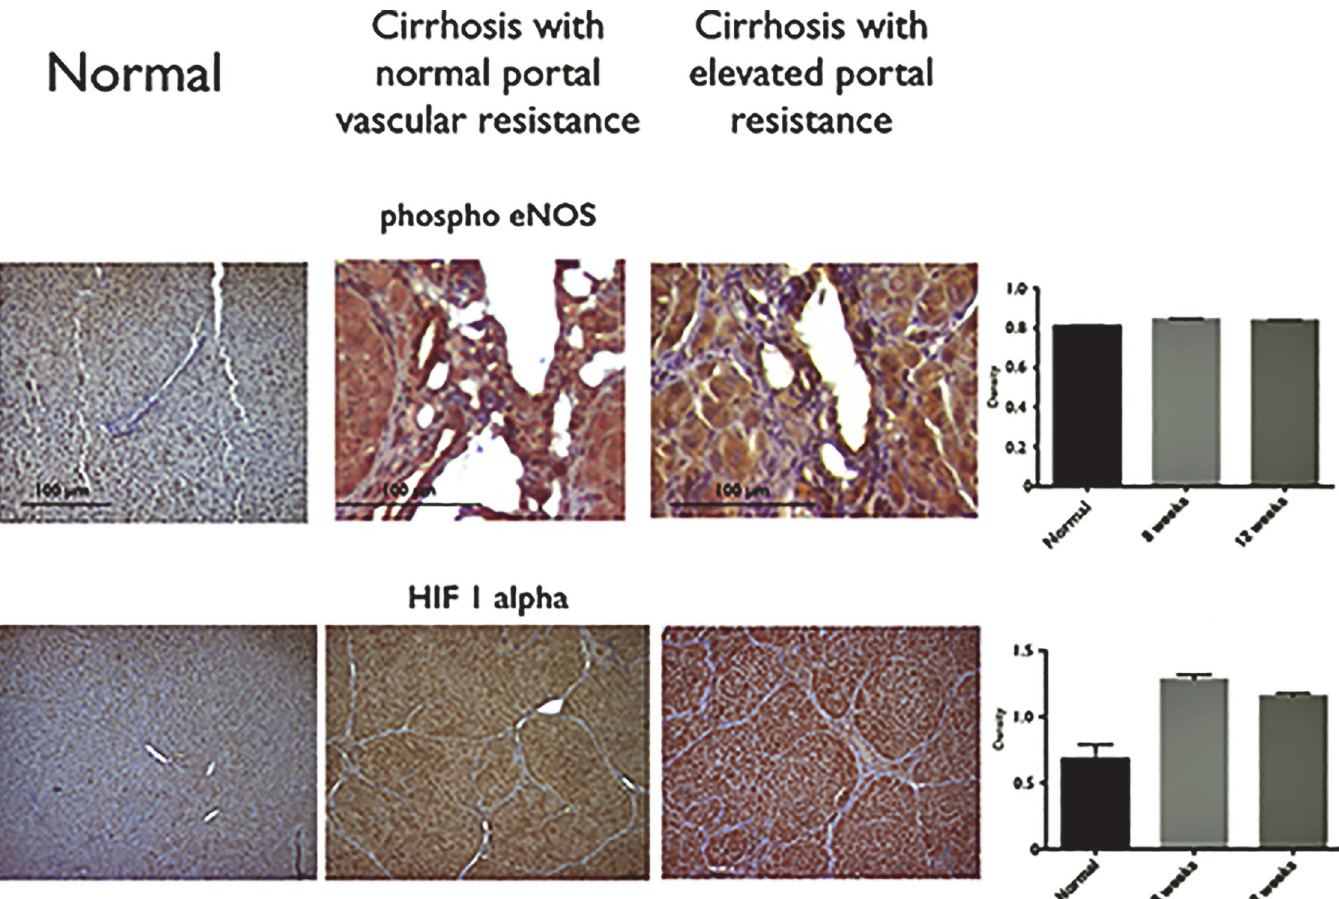
Fig 4. Results of Western Blot showing HIF-1 alpha (liver samples) and eNOS expression (hepatic artery samples). HIF-1 alpha was significantly higher in cirrhotic rats with elevated portal resistance (n = 7; p = 0.05). Rats with normal portal resistance (n = 6; p = 0.66) showed an expression between the other two groups with slightly lower expression of HIF-1 alpha compared to cirrhotic rats with elevated portal resistance and slightly higher expression compared to normal (n = 7; p = 0.73). Expression of eNOS was significantly higher in both, cirrhotic with normal portal resistance (p = 0.03) and with elevated portal resistance (p = 0.02) compared to